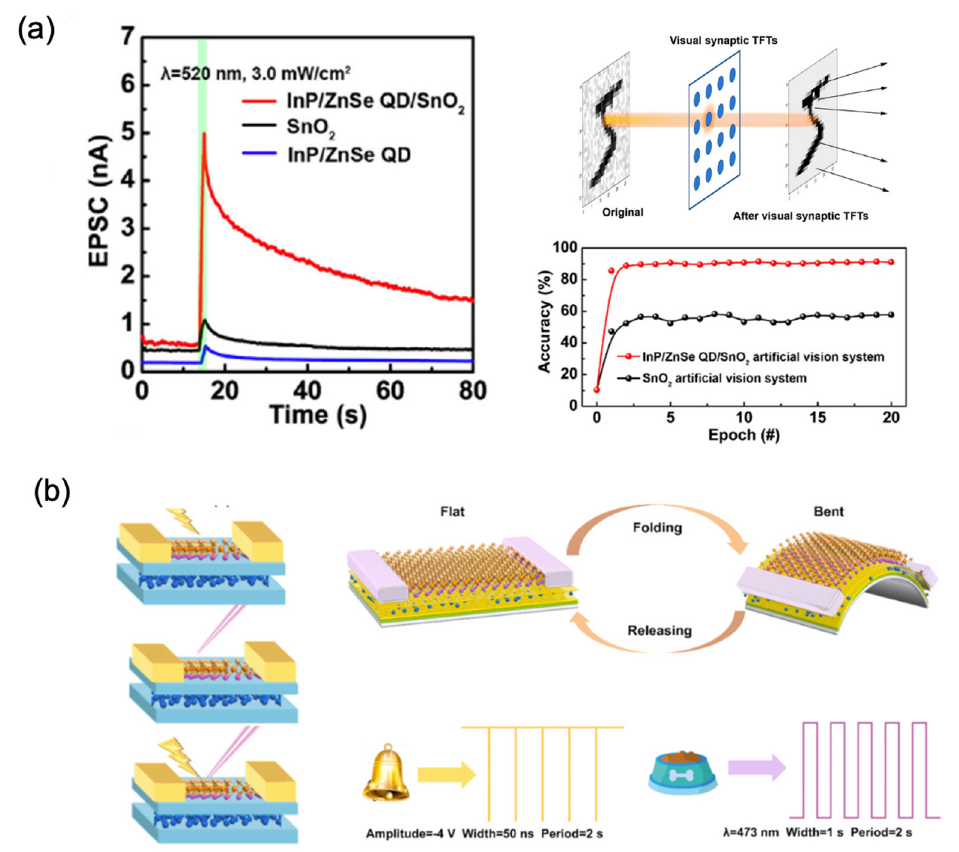
Figure 8. ( a ) The synaptic behavior of the InP/ZnSe QD/SnO 2 structure artificial synapse discussed in Figure 2 and the image-recognition rate after training with InP/ZnSe QD/SnO 2 and base SnO 2 synaptic TFTs, based on an artificial-vision system [51] Reprinted/adapted with permission from Ref. [51] Meng, 2021. ( b ) Schematic diagram of different modulations of a 2D MoSe/0D BPQDs-